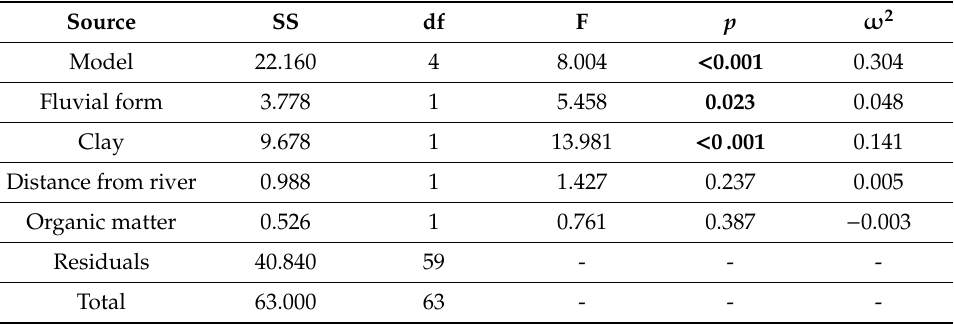
Table 5. Summary of GLM performed with RC2 (SS: Sum of Squares, df: degree of freedom, F: F-statistic, p : significance, ω 2 : e ff ect size; p < 0.05 is highlighted with